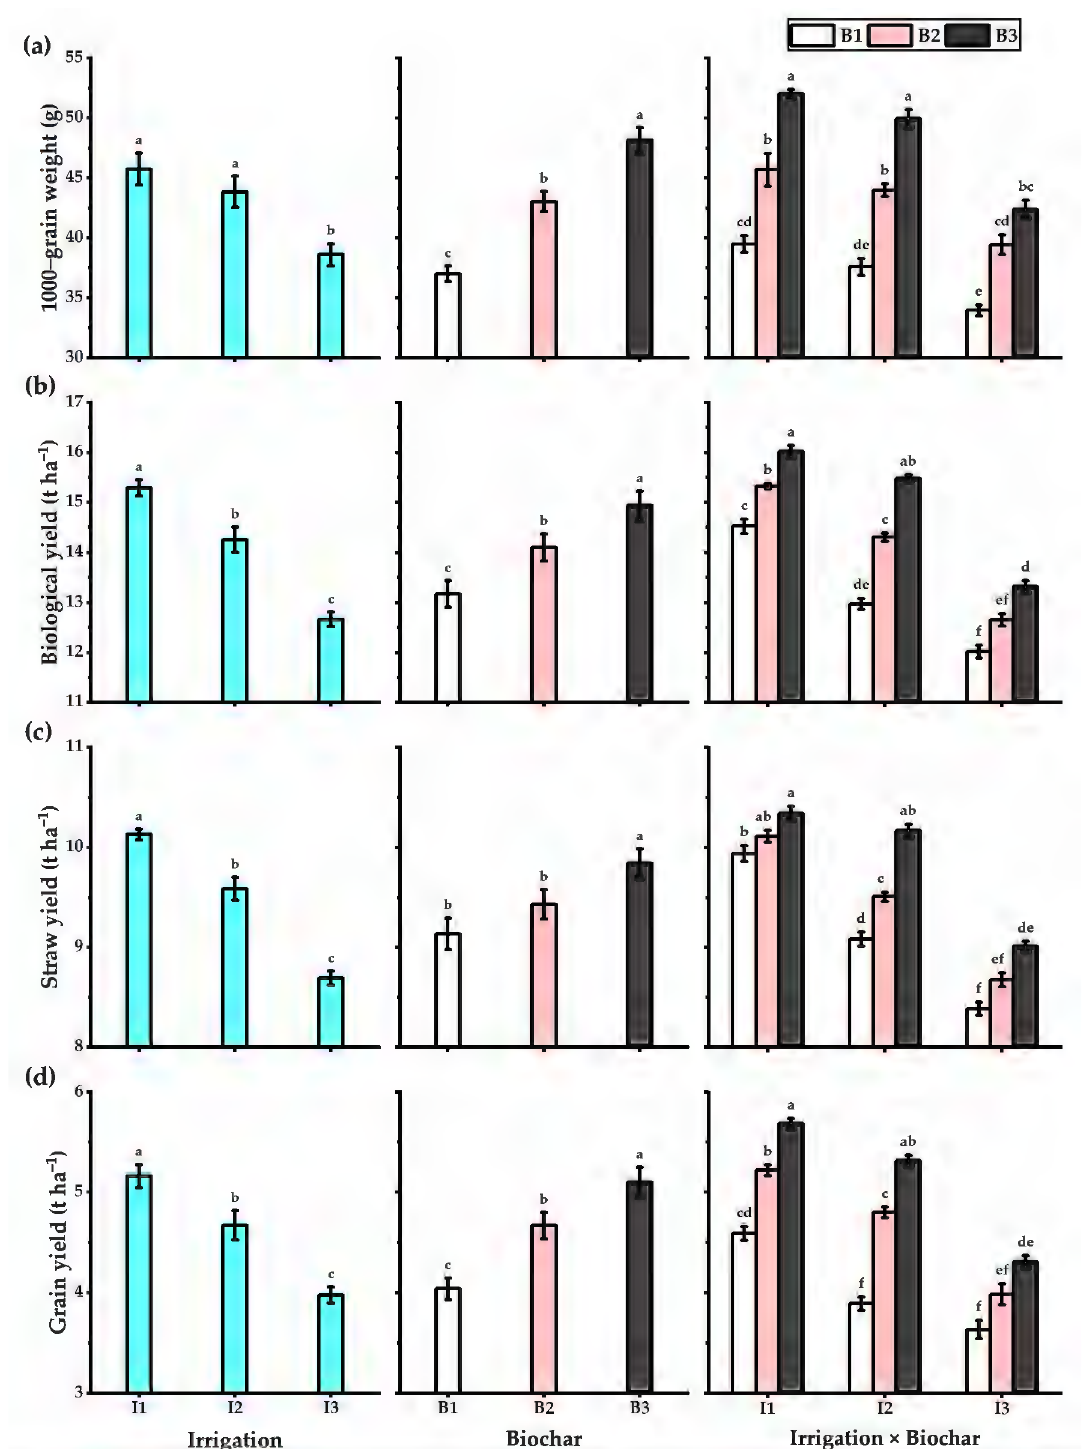
Figure 3. ( a ) 1000-grain weight (g), ( b ) biological yield (t ha − 1 ), ( c ) straw yield (t ha − 1 ), and ( d ) grain yield (t ha − 1 ) of the wheat plants affected by three irrigation levels of 100 (I1), 80 (I2), and 60% (I3) of crop evapotranspiration (ETc), and three levels of biochar soil supplementation, 0 (B 1 ), 7.5 (B 2 ), and 15 t ha − 1 (B 3 ). Bars and error bars represent the means ± SE, respectively, of three biological replicates. Different letters reveal statistically significant differences among